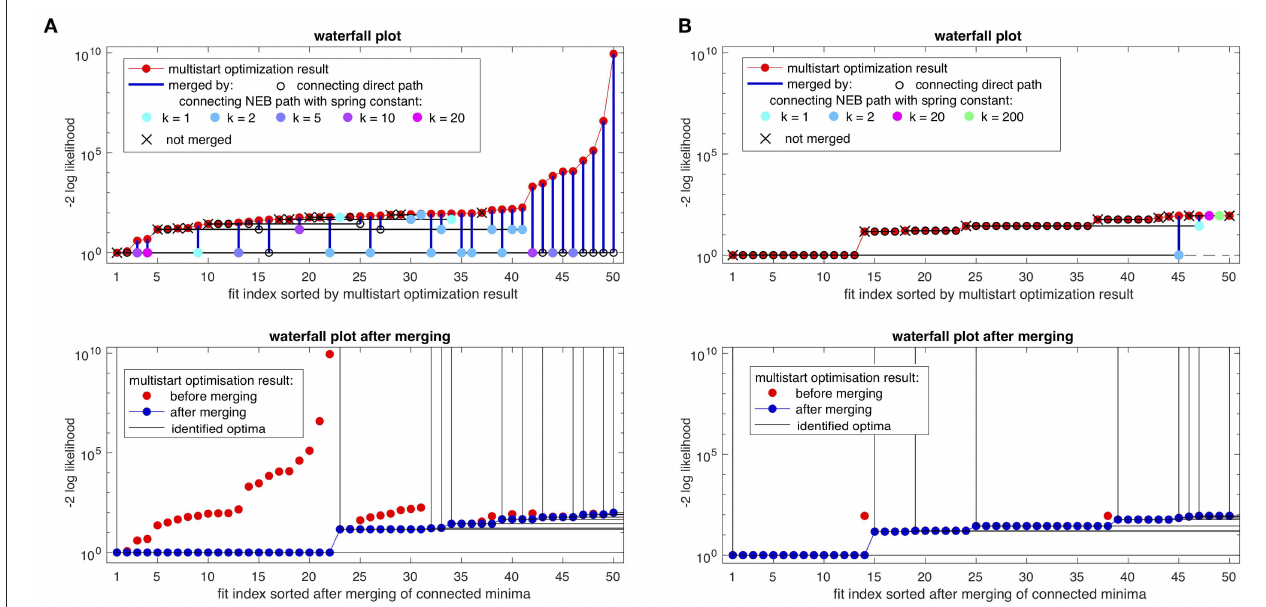
FIGURE 6 | Merged waterfall plots. In (A) with the intentional suboptimal optimization setup and in (B) with the standard optimization setup. The top row shows the waterfall plot before merging the fits based on found connecting paths, indicated by the colored circles on the level of the corresponding first representative of the connected optimum. The colors indicate the first successful connecting path using a spring constant from the set k = { 200,100,50,20,10,5,2,1 } . The bottom row shows the resulting merged and reordered waterfall plots. For illustration, likelihood values are shifted to the baseline by subtraction of the likelihood value for the global